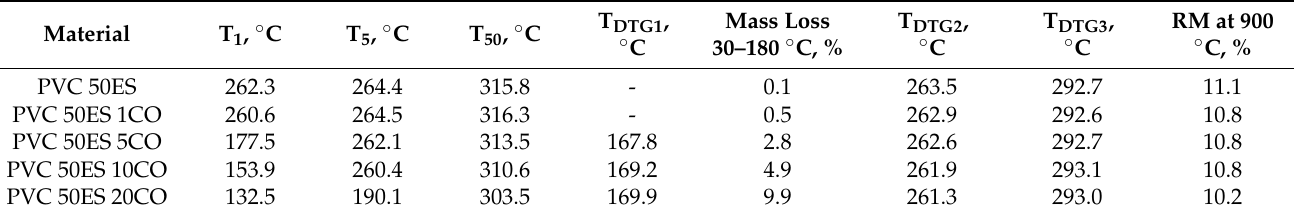
Table 3. The TGA analysis